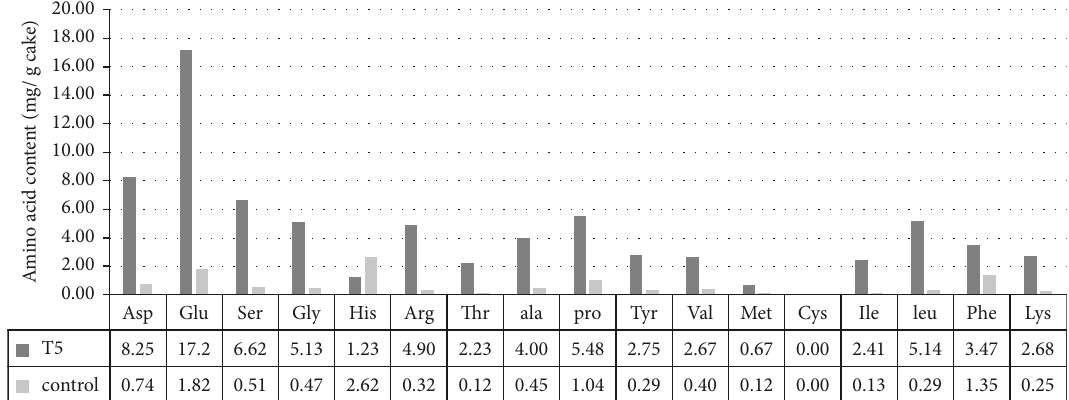
0 . 05 probability level. The data are <